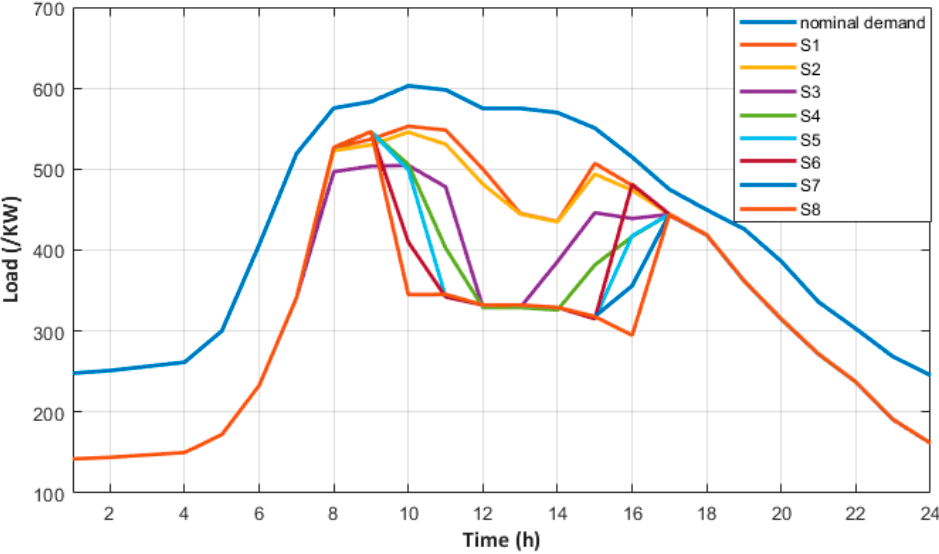
Figure 8. Nominal demand and demand per scenario for 2 January 2019. (source: Authors).